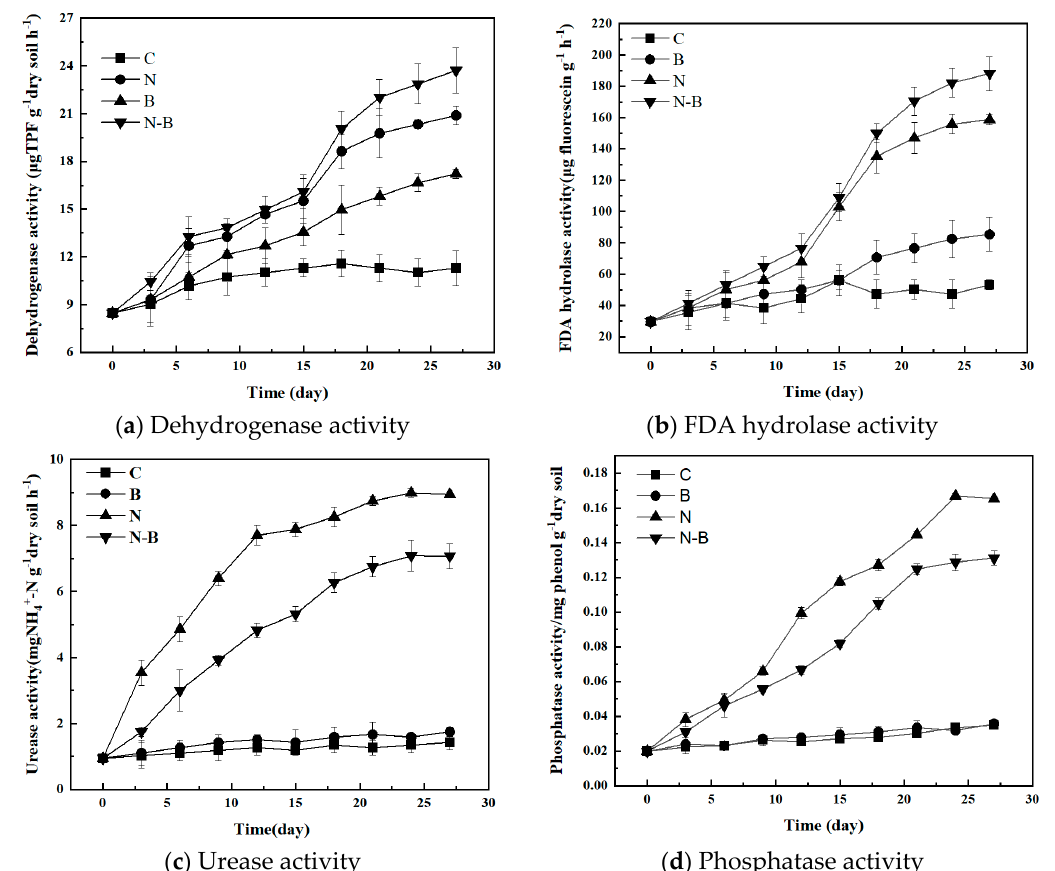
Figure 3. The changes of enzyme activity during different bioremediation processes.